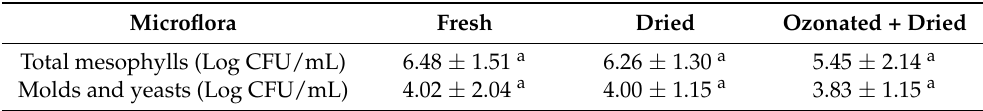
Table 3. Effect of freeze-drying on the intrinsic microflora of fresh and ozonated melon peel. The values are mean ± margin of confidence intervals at 95%.